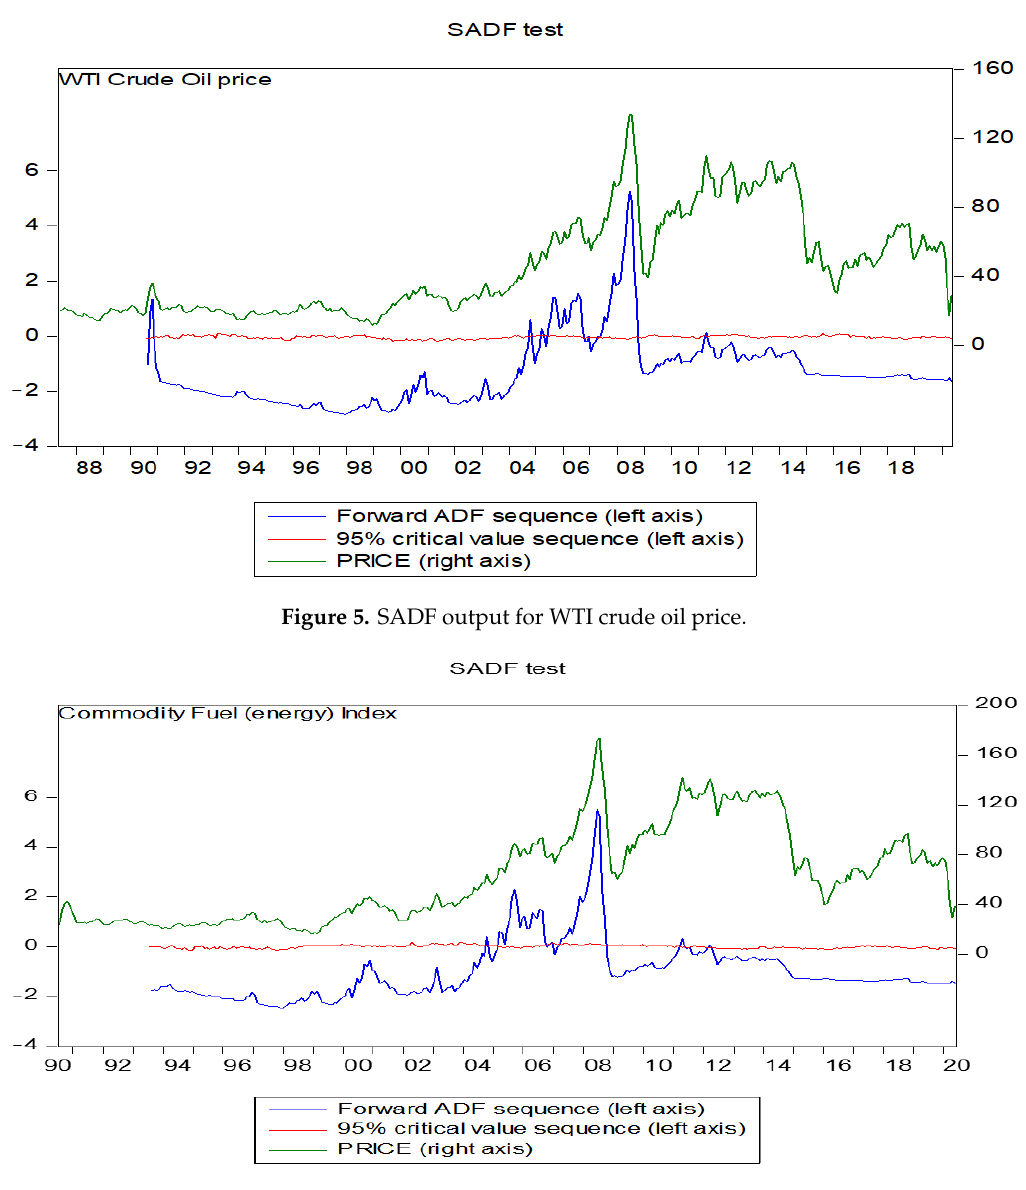
Figure 6. SADF output for CEI.